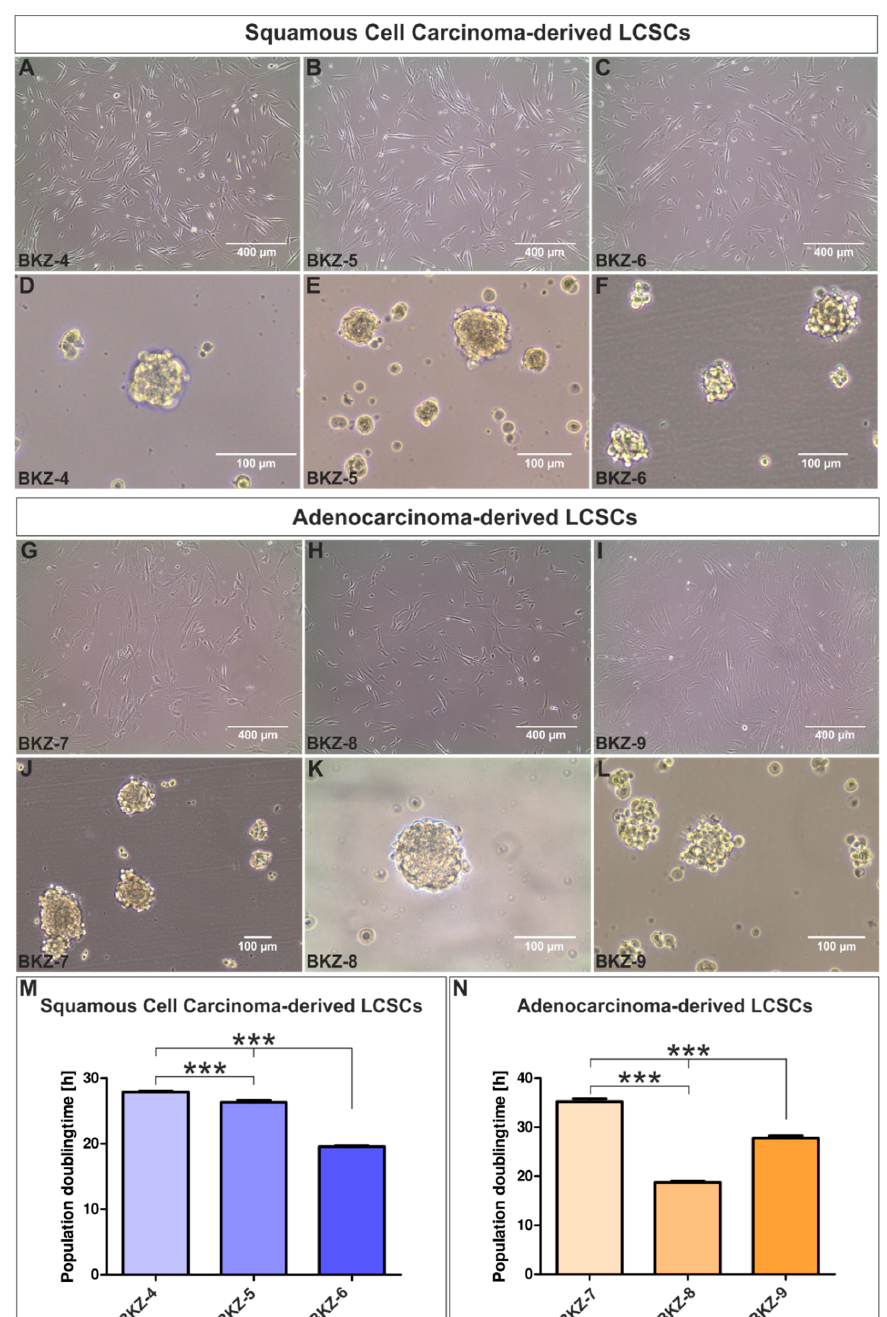
Figure 1. Successful isolation of squamous cell carcinoma (SCC)-derived lung cancer stem cell (LCSC)-like cell populations: ( A ) BKZ-4, ( B ) BKZ-5, and ( C ) BKZ-6. ( D–F ) Serum-free cultivation of the isolated cell populations led to the formation of free-floating cancer organoids for all three SCC-derived cell populations. Isolated adenocarcinoma (AC)-derived lung cancer stem cell-like cell populations could be also grown as ( G–I ) adherent culture as well as ( J–L ) sphere culture. ( M ) Analysis of the population doubling times of the adherent SCC-LCSCs revealed a higher population doubling time for BKZ-4 in comparison to BKZ-5 and BKZ-6, with BKZ-6 revealing the lowest doubling time. ( N ) Quantification of the population doubling times for the different AC-LCSC depicted a significantly higher population for BKZ-7 in comparison to BKZ-8 and BKZ-9. Further, population doubling time of BKZ-9 was significantly higher when compared to BKZ-8. Unpaired t -test ( p ≤ 0.05). n = 9, *** p ≤ 0.001. Mean ± SEM (standard error of the